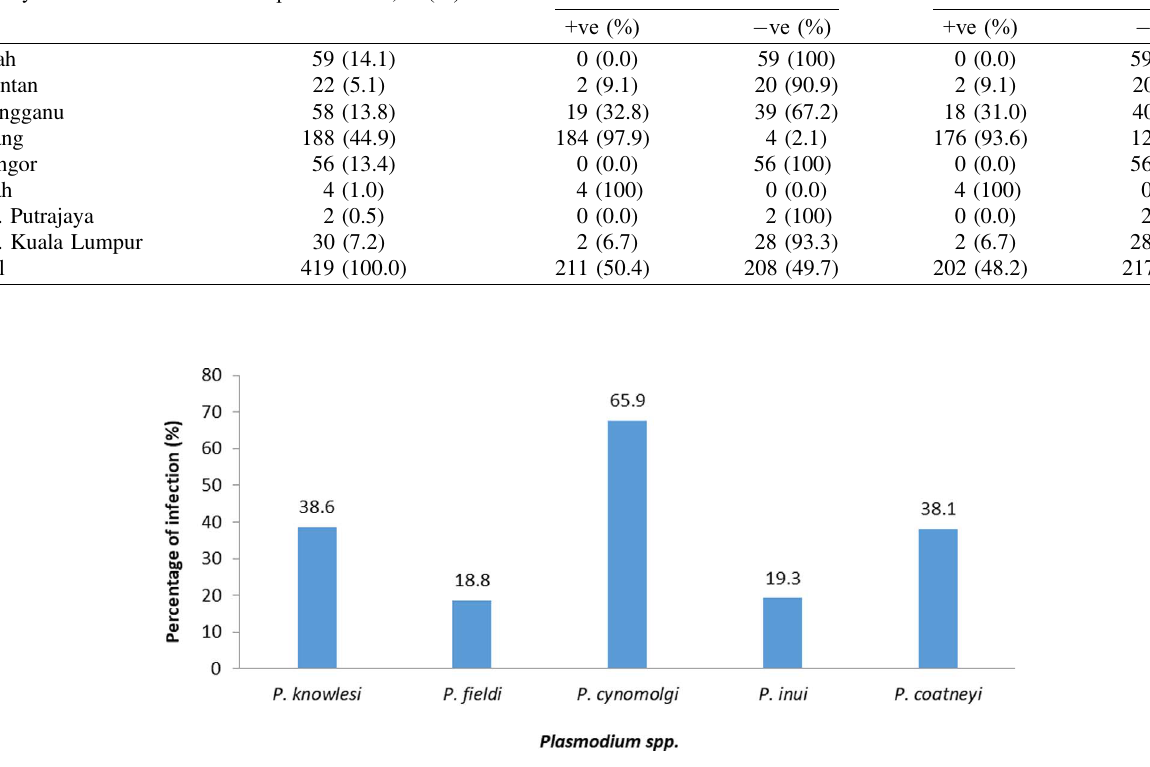
Figure 3. Macaque malaria as detected by Nested PCR. The most common Plasmodium spp . that was found in 176 selected Malaysian macaques was P. cynomolgi, followed by P. knowlesi, P. coatneyi, P. fi eldi, and P. inui. Although P. knowlesi infection was not the most common in these macaques, it is by far the most fatal zoonotic malaria in